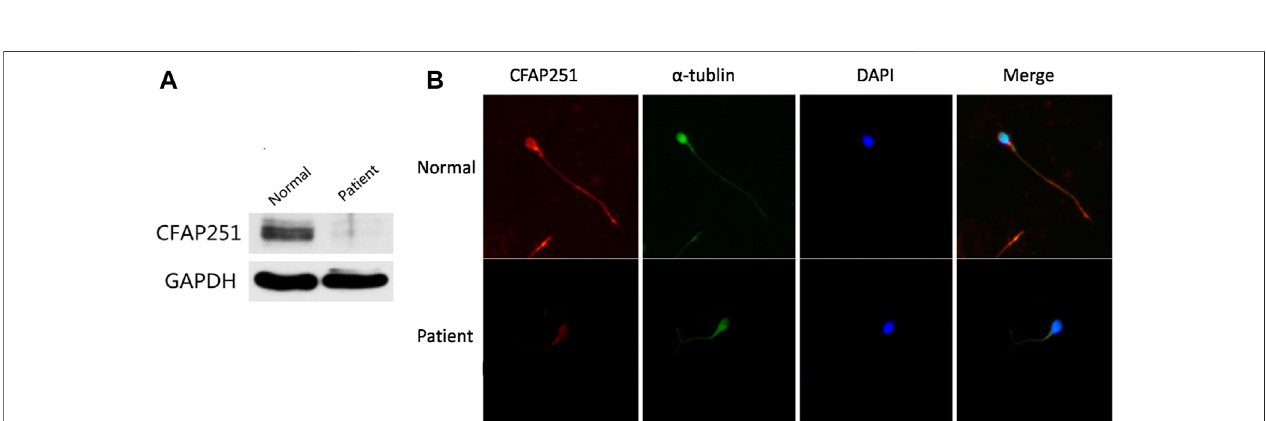
FIGURE5| ExpressionandLocationAnalysisofCFAP251ProteininSperm. (A) Immunoblottinganalysisofproteininspermlysatesfromanormalcontrolandfrom men harboring the CFAP251 mutation. GAPDH was used as a loading control. (B) The spermatozoa were stained with anti-CFAP251 (red) and anti- α tubulin (green) antibodies. Tubulin antibody staining indicates fl agella, and DAPI staining indicates the nucleus of spermatozoa. Compared with the normal control, CFAP251 protein is absent from the sperm fl agella of patients.